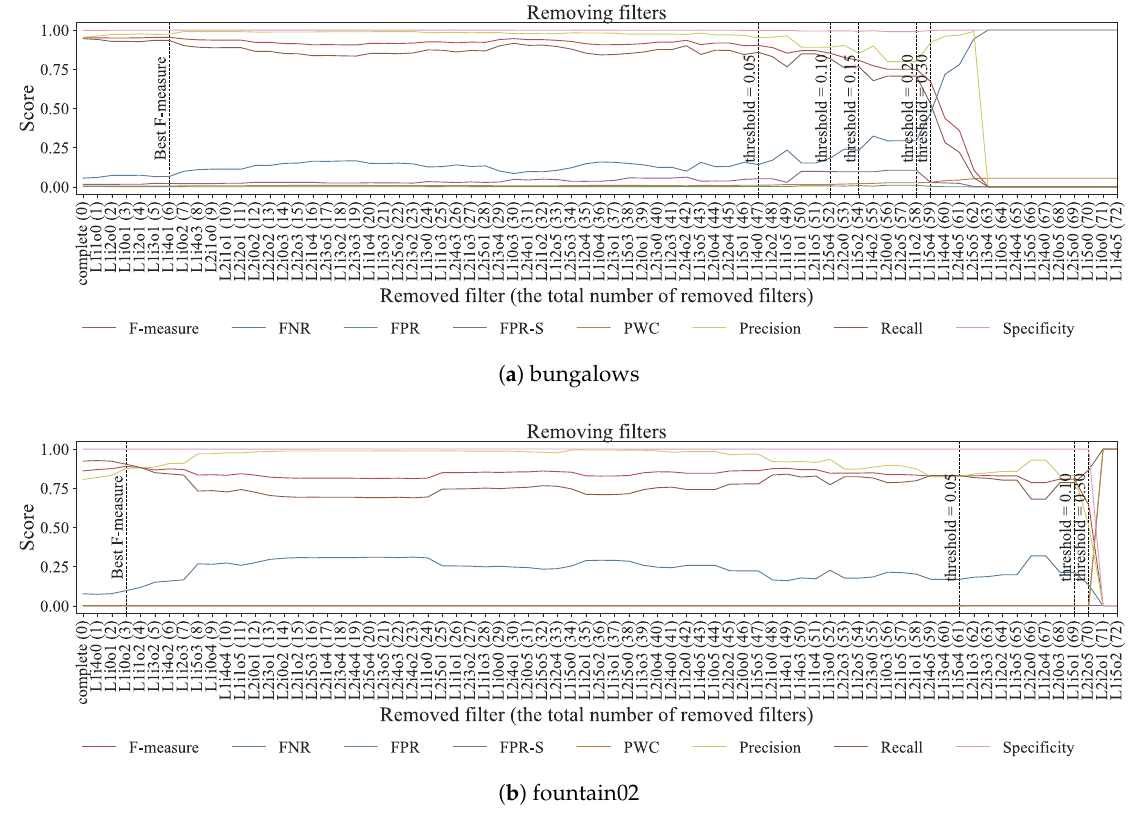
Figure 9. Visualization of detection accuracies when some filters are removed. The name of removed filters denotes a layer, input channel, and output channel. For example, L1i2o3 represents the 2D filter in the 1st layer, the 2nd input channel and the 3rd output